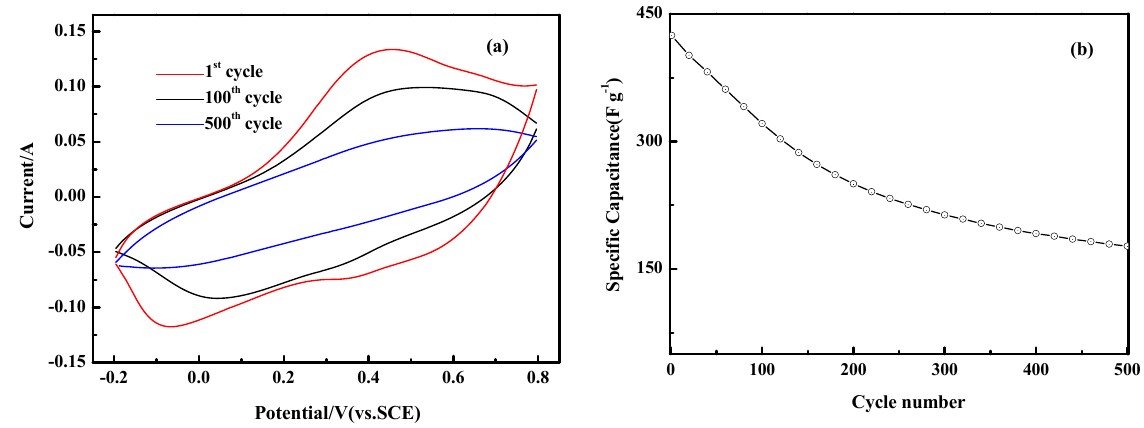
Figure 9. Electrochemical impedance spectroscopy of PANI-0.5 at open-circuit potential with ac-voltage amplitude of 5 mV over the frequency range of 10 − 2 –10 5 Hz in 1 M H SO electrolyte ； the inset shows the enlargement of a part of Electrochemical 2 4 impedance